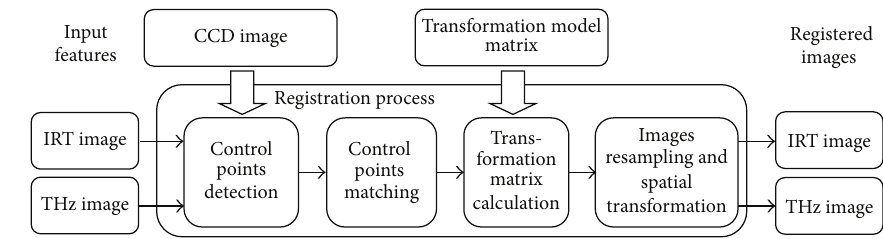
Figure 8: The functional block diagram of the data registration